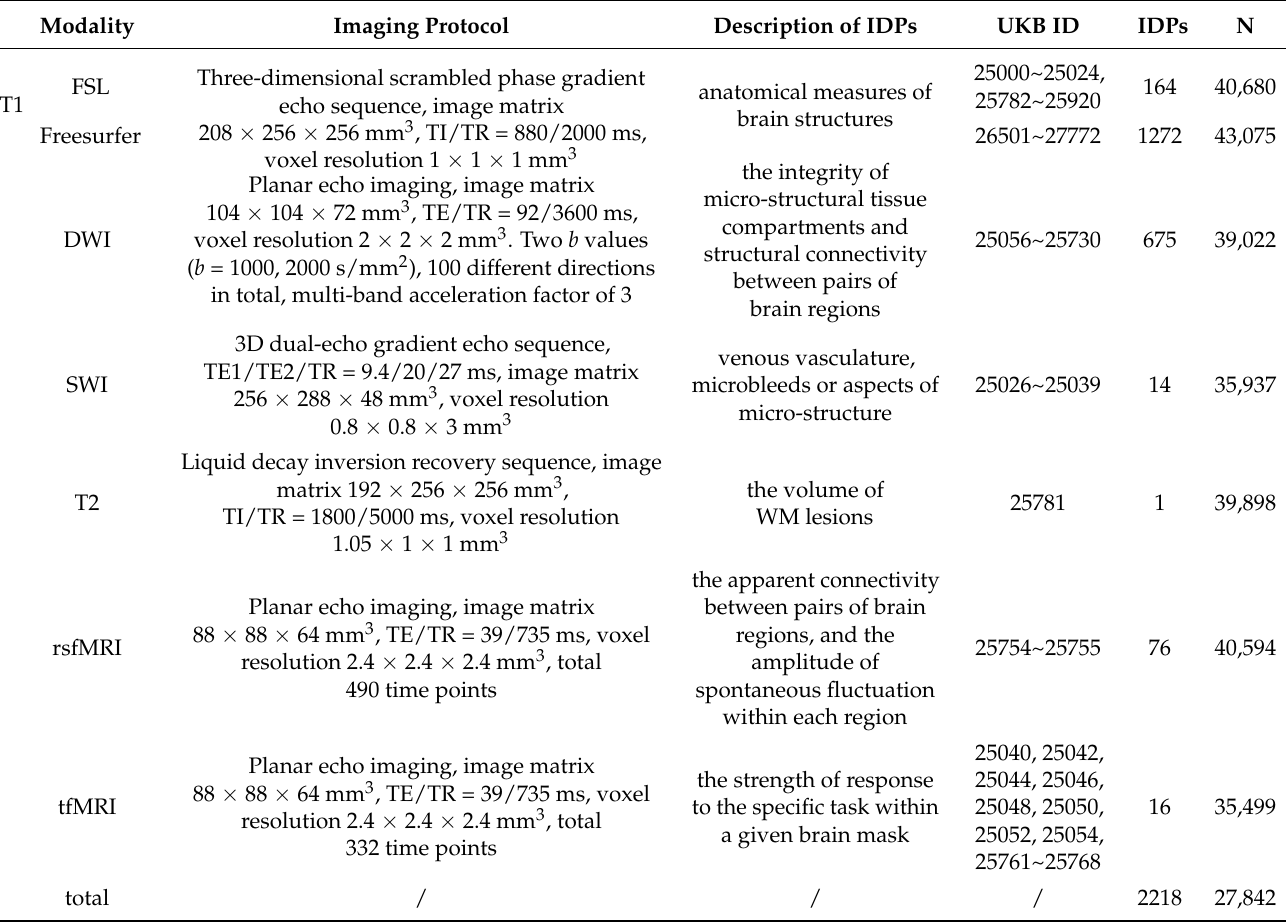
Table 2. Description of